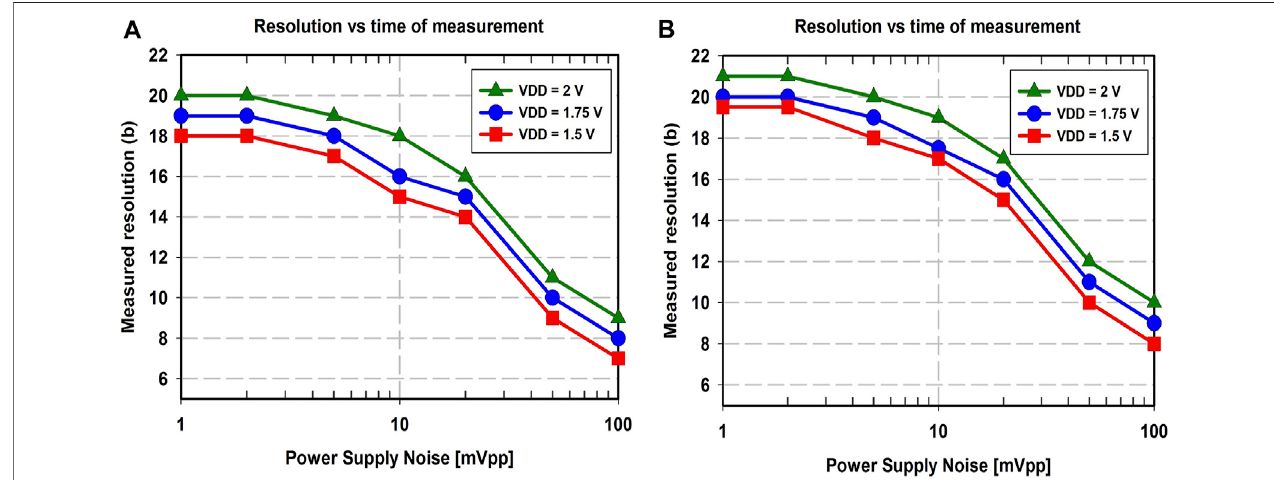
TABLE 1 | Measured performance summary of the three-design time-based RDC and comparison table